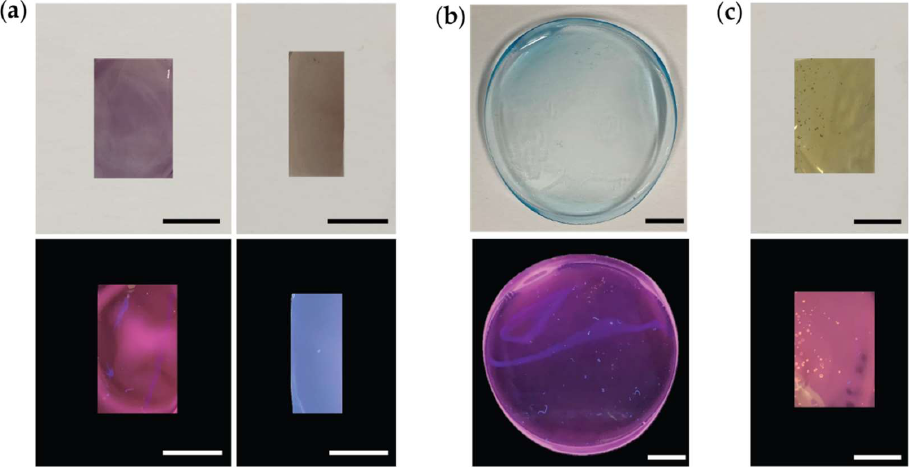
Figure 1. Photographs of ( a ), from left to right, R-PE/PVA and R-PE/alginate, ( b ) C-PC/PVA, and ( c ) FX/PVA under white light ( top ) and UV irradiation at 365 nm ( bottom ). Scale bars: 10 −2 m.